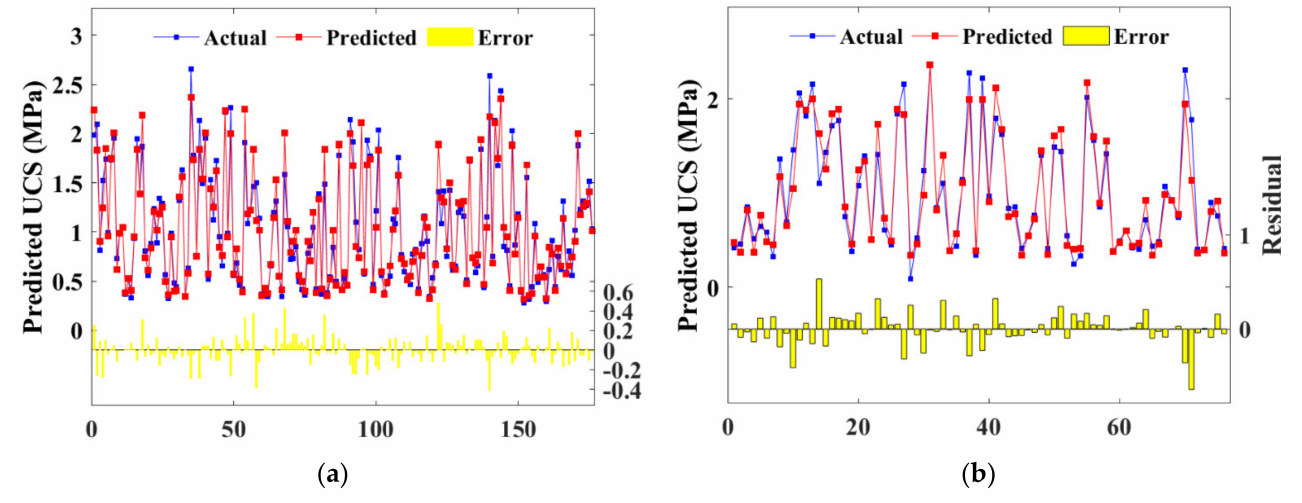
Figure 14. Scatter plot of predicted and actual UCS of BPNN model: ( a ) training set; ( b ) test